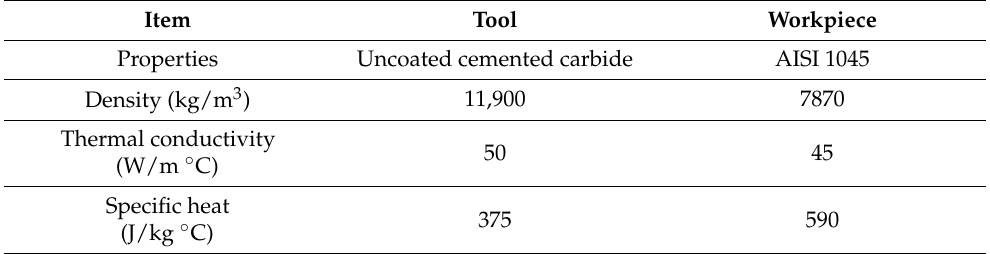
Table 1. Thermal and physical properties of workpiece and tool materials (adapted from [11,12]). Item